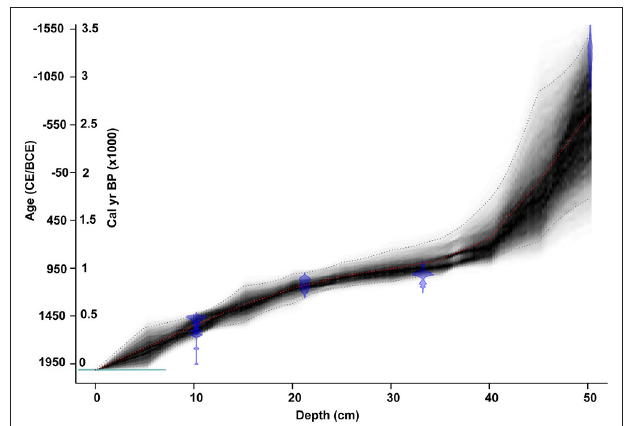
FIGURE 3 | Age-to-depth model for the Quan Lan wetland. The graph shows the Bacon-calibrated 14 C dates (transparent blue) and the age-depth model (darker grays indicate more likely calendar ages; gray stippled lines show 95% confidence intervals; red curve shows single “best” model based on the mean age for each